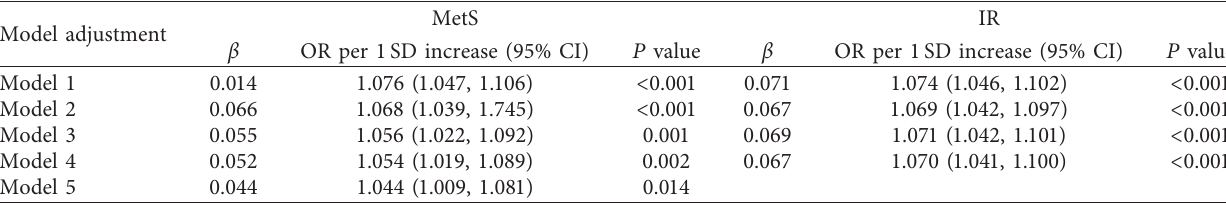
Table 3: Association of serum asprosin with MetS and IR in fully adjusted models.